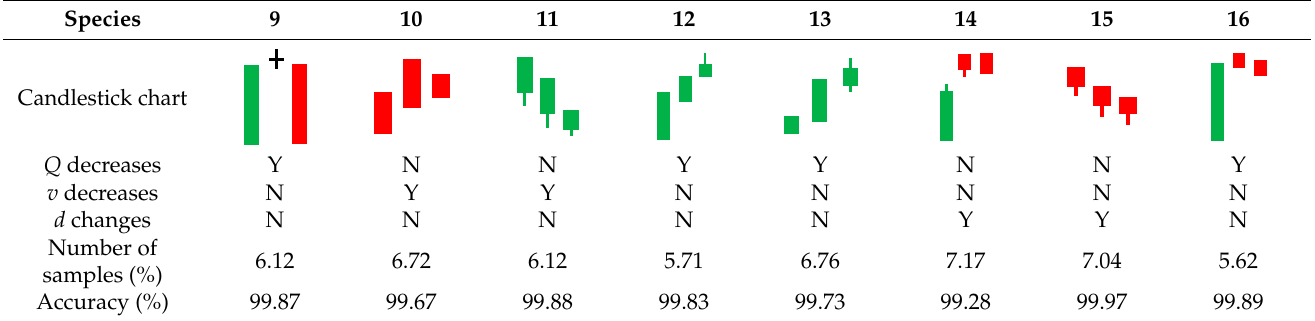
Table 5. Eight categories of the candlestick chart combinations for PM 2.5 declines. Species